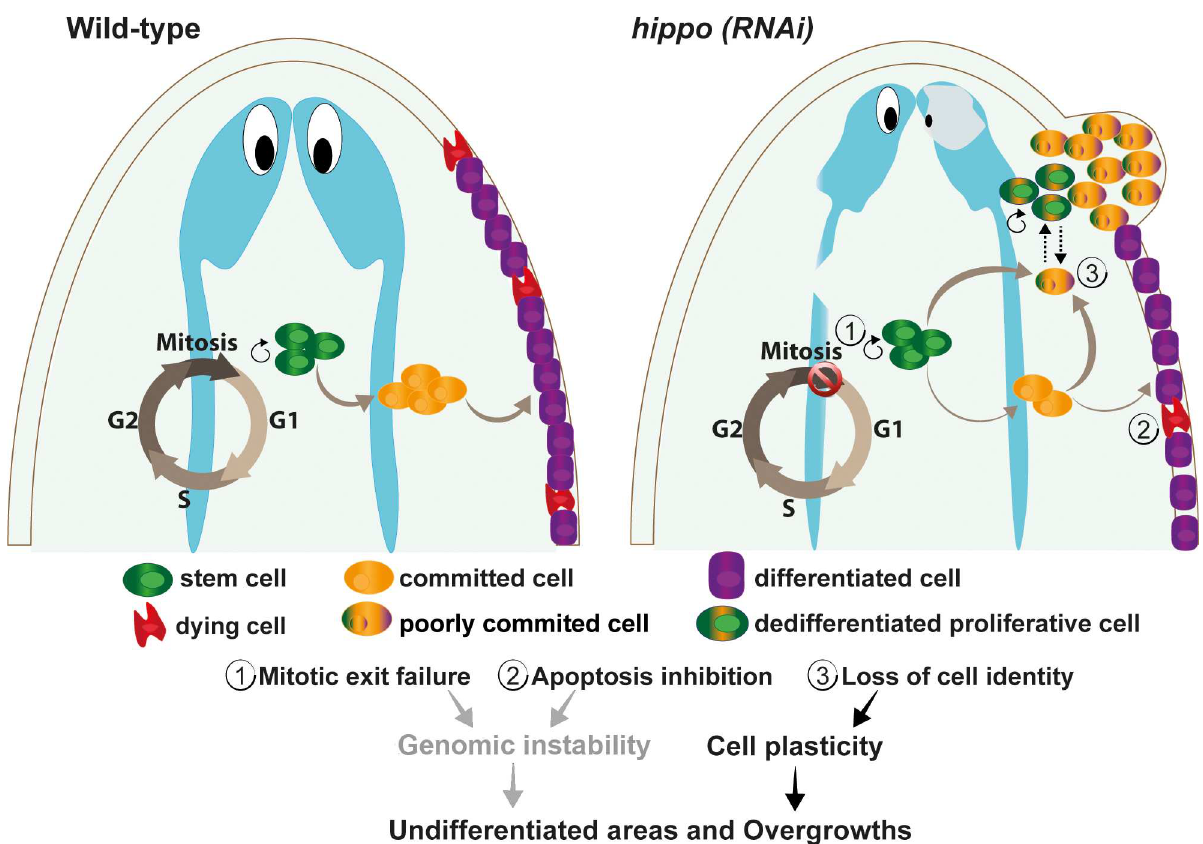
Fig 7. Model of the hippo function in planarians. In wild-type animals, stem cells or neoblasts can proliferate or can become committed and differentiate into specific cell types. Committed cells exit the cell cycle to proceed to the differentiation process. The health and number of postmitotic cells is also controlled by programmed cell death. In hippo (RNAi) planarians, proliferating stem cells or neoblasts become trapped in M phase (1), and fewer of these cells undergo apoptosis (2). Both alterations may lead to genomic instability, because the failure to exit M phase is linked to DNA damage, and inhibition of the apoptotic response hampers the elimination of damaged and old cells. hippo inhibition also promotes cell plasticity and facilitates cell dedifferentiation (3). Both genomic instability and cell plasticity could promote the appearance of undifferentiated areas and overgrowths. RNAi, RNA